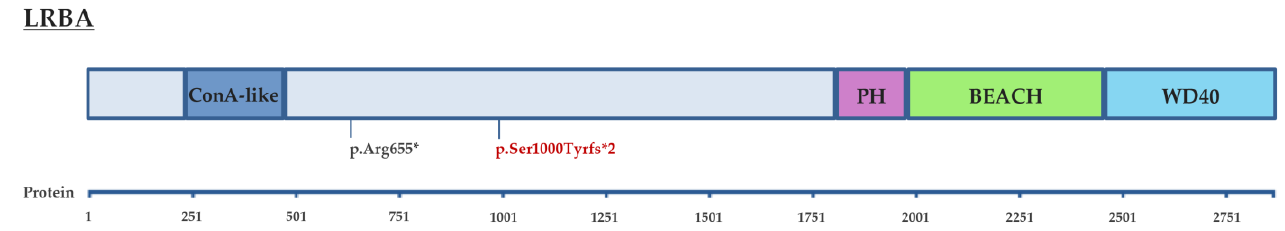
Figure 1. LRBA schematic protein domains map and location of the identified mutations. ConA-like: conconavalin A-like domain (186–371, 186 aa). PH: PH Pleckstrin homology domain (2073–2181, 109aa). BEACH: BEACH domain of Beige and Chediak-Higashi. WD40: WD40 repeat-like containing domain.